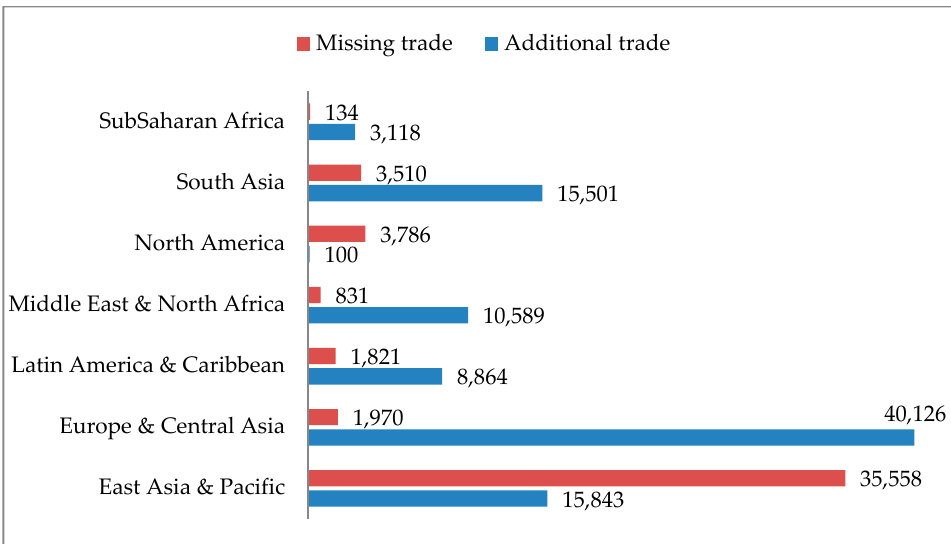
Figure 5. Trade effect due to preference: Results by countries according to regions (CES reference tariff). At world prices; millions of €. Source : Elaboration on data by COMEXT and TRAINS; 2017.